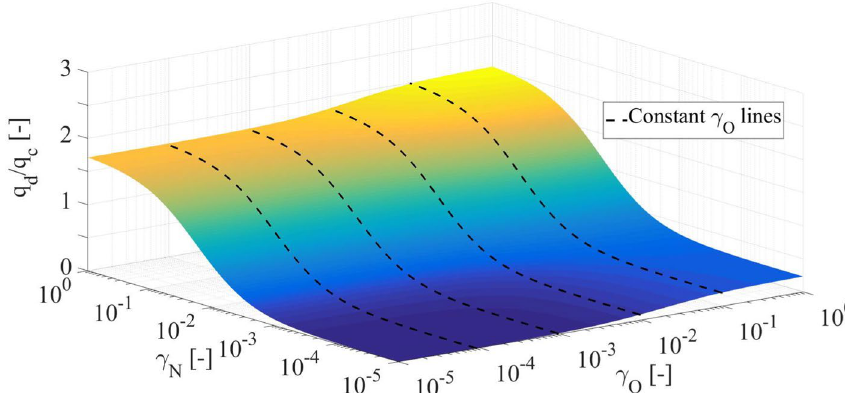
Fig. 17 Surface plot of oxygen and nitrogen catalytic efficiency on the diffusion heat transfer